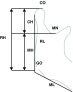
Landmark points of vertical mandibular symmetry according to Kjellberg’s technique.